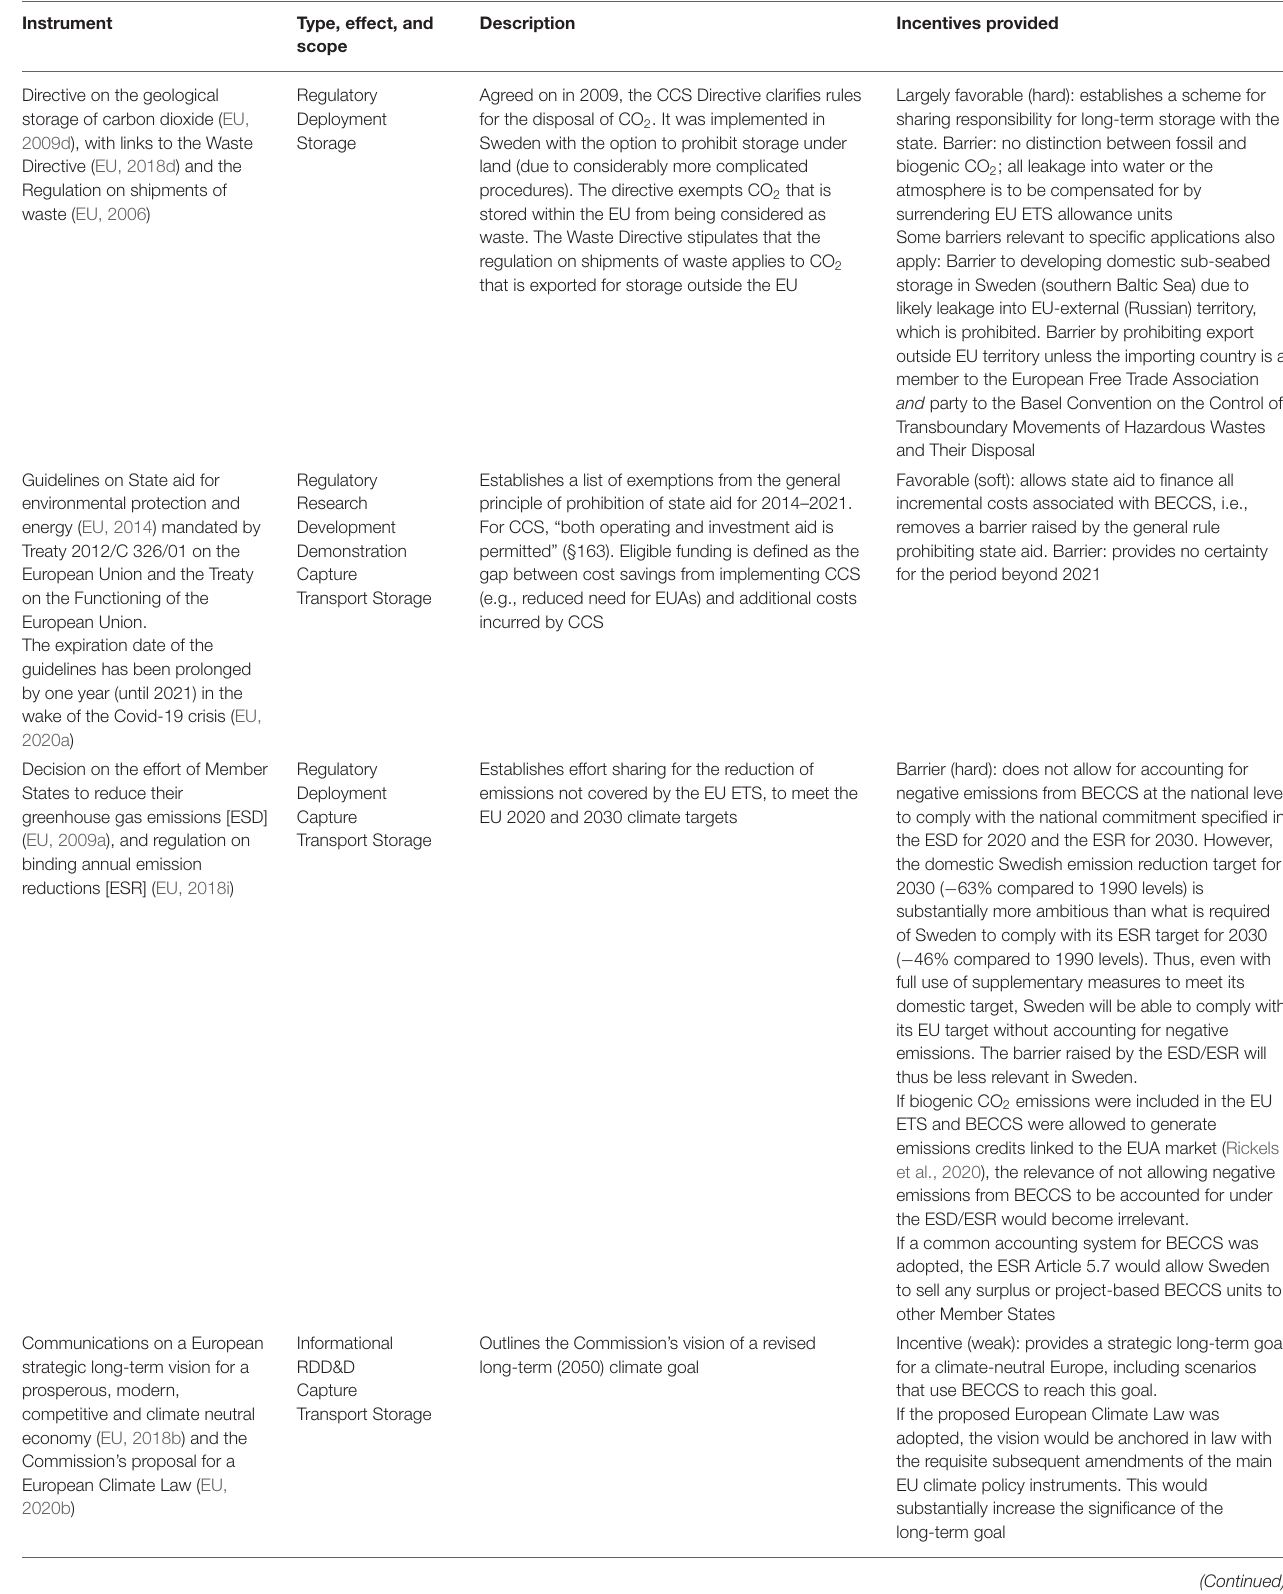
TABLE 5 | Supranational (EU) regulatory and informational policy instruments of direct relevance to BECCS RDD&D in Sweden, in descending order of